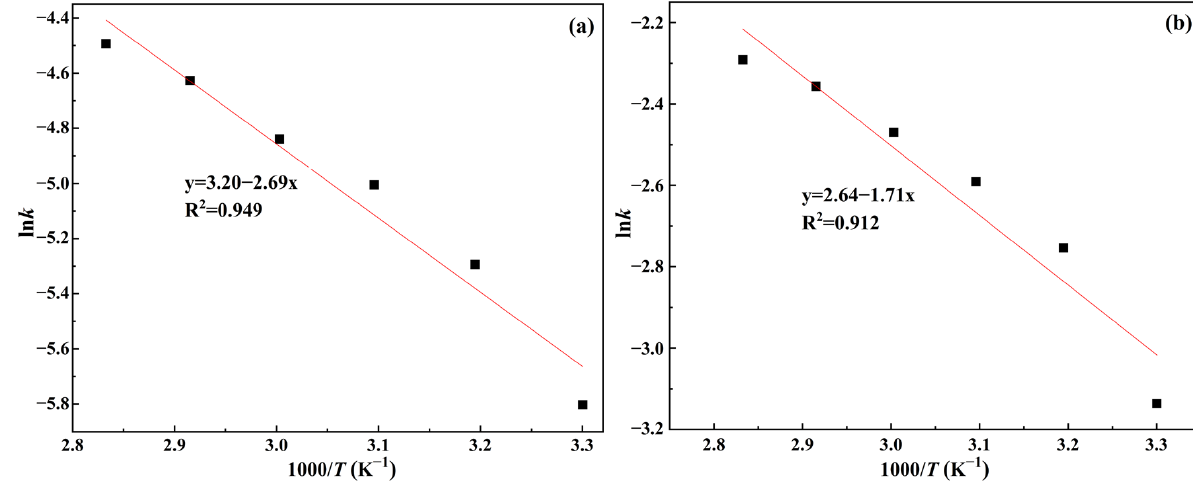
Figure 14. Arrhenius plot of lnk vs. 1/T: ( a ) the first stage; ( b ) the second stage.